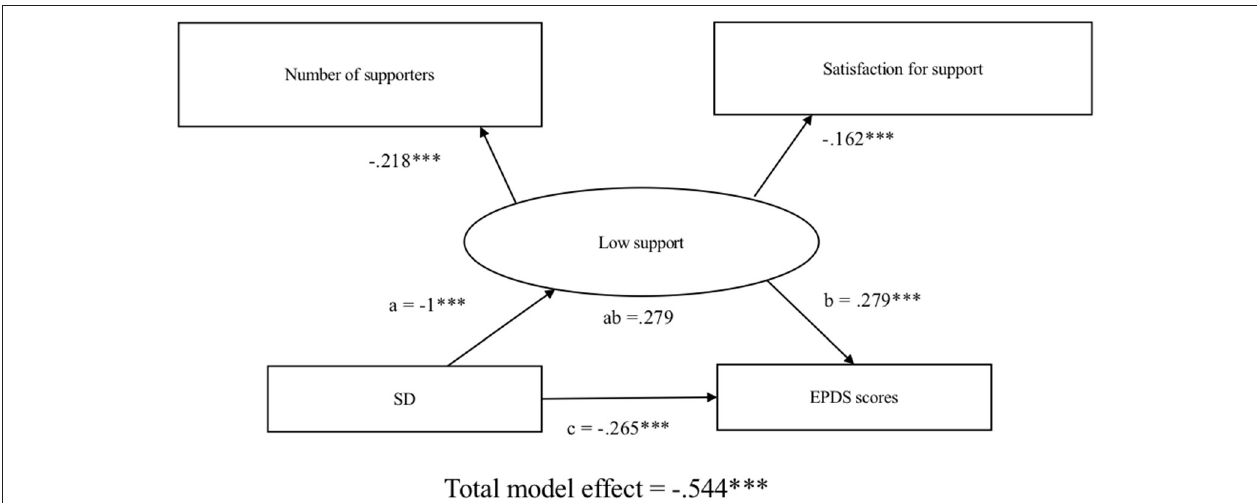
FIGURE 3 | Structural equation modeling of self-directedness, social support, and postpartum depressive symptoms. Observed measures are represented by squares and latent variables are represented by circles. Single-headed arrows (path) define causal relationships between variables. Numbers represents standardized coefficient. a, effect of SD on low support; b, effect of low support on EPDS total scores; c, direct effect of SD on EPDS total scores; ab, indirect effect of SD on EPDS total scores. SD, self-directedness; EPDS, Edinburgh Postnatal Depression Scale. * P < 0.05, ** P < 0.01, *** P <